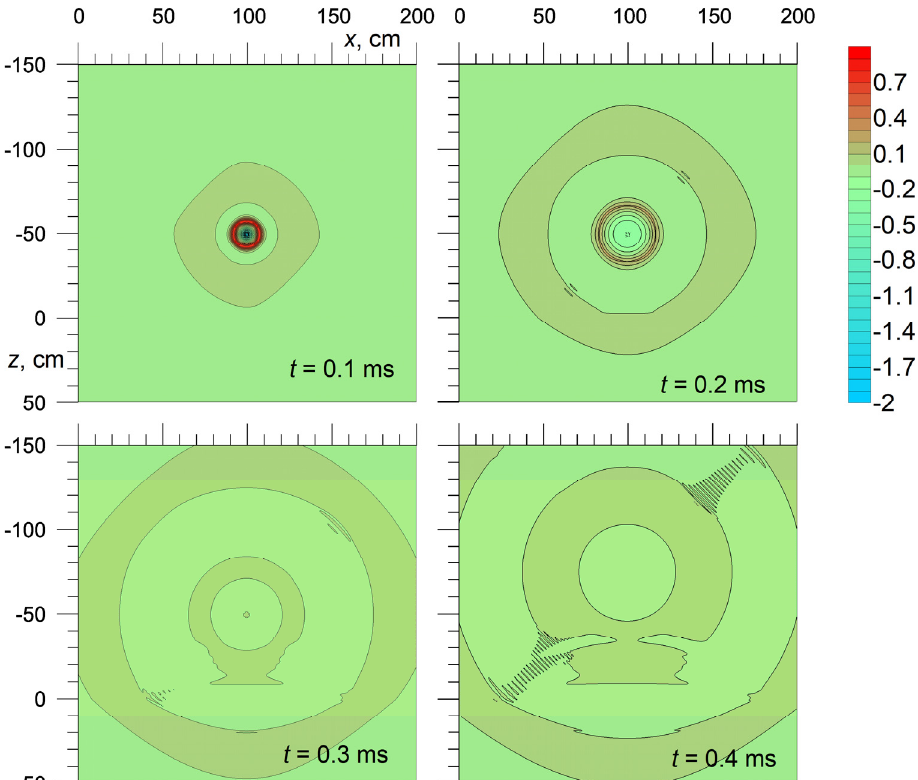
Figure 5. The fields of average pressure in a liquid ∆ p l / p 0 during the propagation of the perturbation from the source and its passage/reflection through the boundary of the porous media and fractured-porous media for several time points. The color scale on the right shows the pressure level ∆ p l / p 0 .